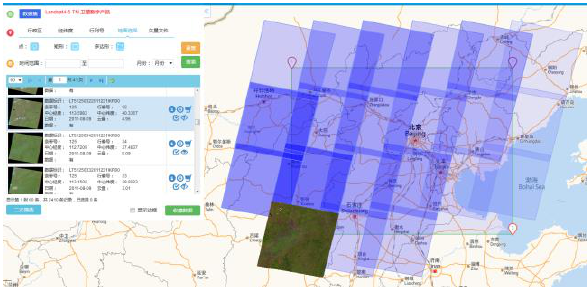
Figure 4. Illustration of experiment data